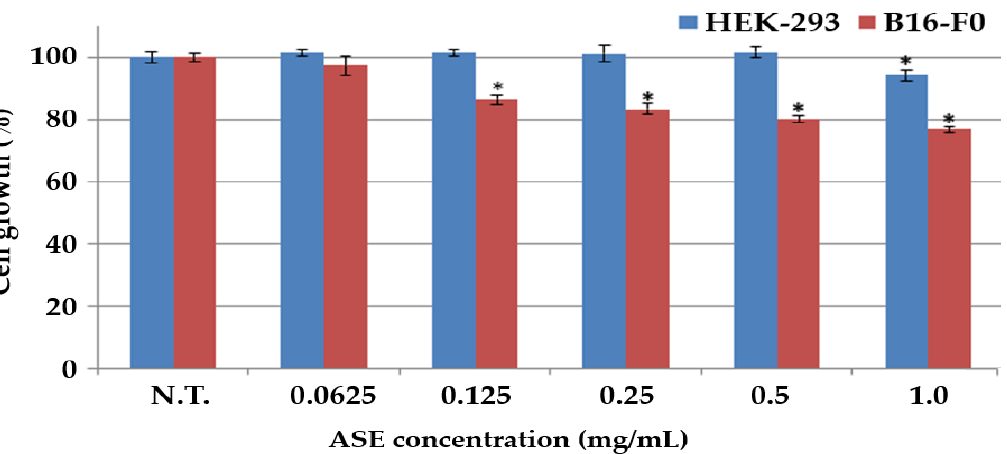
Figure 1. Comparison of cytotoxic effects of ASE on melanoma cells (B16-F0) and normal cells (HEK- 293). The cell growth of the control group with the nontreated group (N.T.) at 24 h was represented as 100%. Results are mean ± standard deviation ( n = 3). The statistical analysis of the data was carried out by use of a Student’s t -test. Values are statistically significant at * p < 0.05 vs. respective control group.